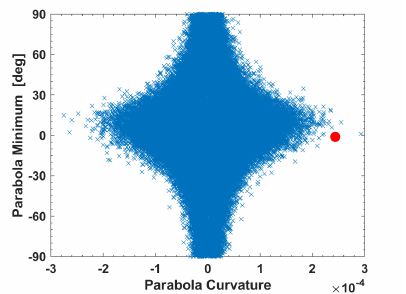
Figure 5. The correlation mean parabola fit curvature, as in Fig- ure 4(b), versus minimum for 200,000 isotropic MC sets shows that a high curvature has a tendency for a minimum near the su- pergalactic plane. The red dot is the data